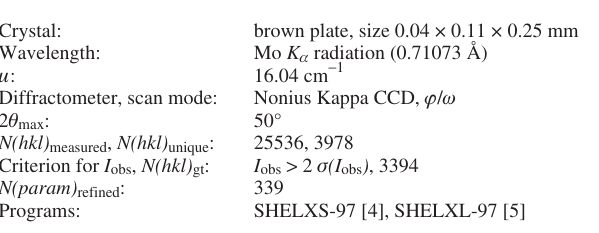
Table 1. Data collection and handling.